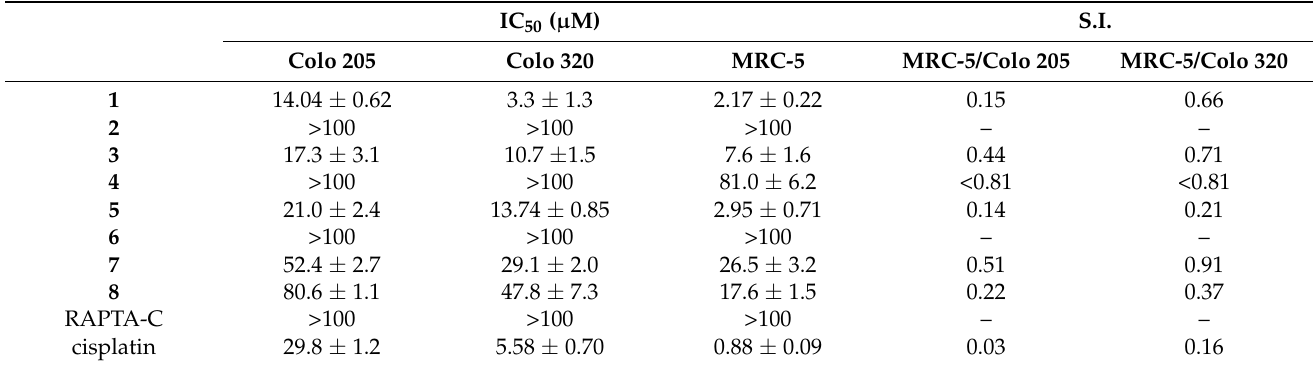
Table 1. IC 50 values of the complexes determined on chemo-sensitive (Colo 205), multidrug resistant (Colo 320) human colonic adenocarcinoma cell lines and normal human embryonal lung fibroblast cells (MRC-5) (72 h), in addition to selectivity indexes (S.I., ratio of the indicated IC 50